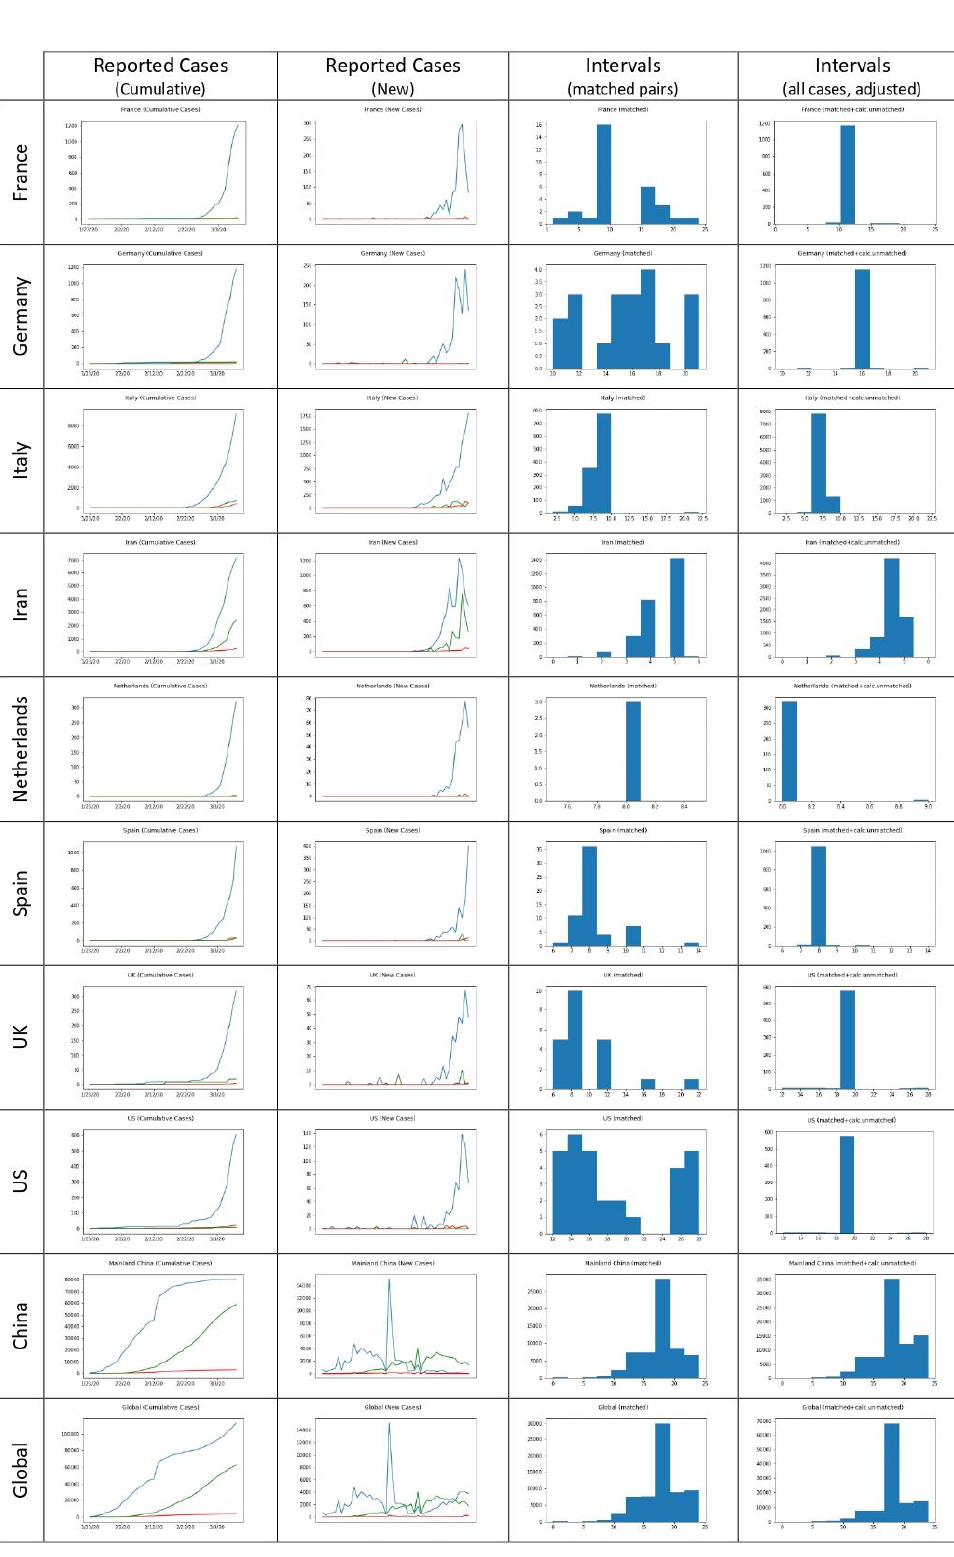
Figure 2. Reported cases, diagrams, and calculated interval